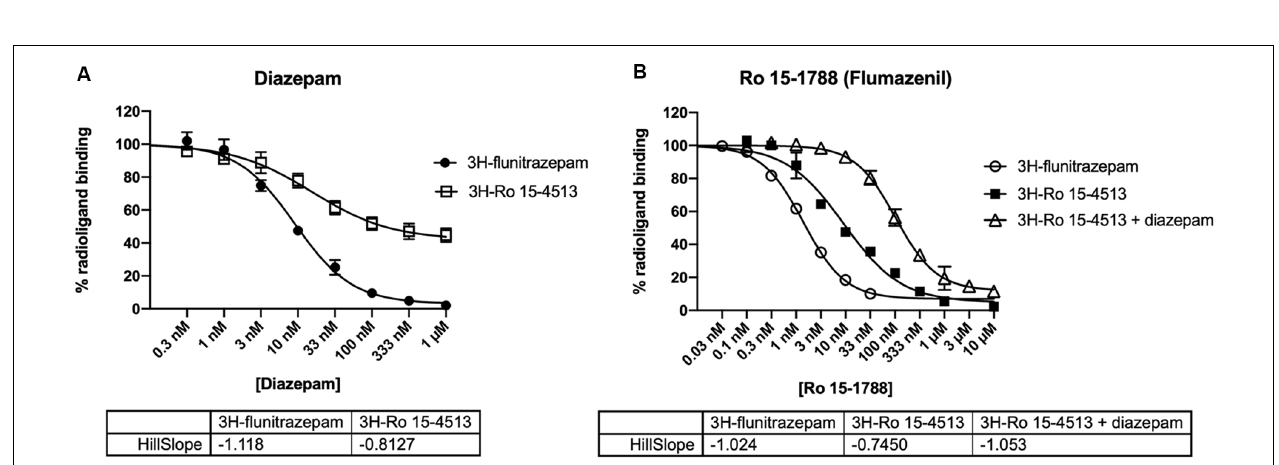
FIGURE 4 | Inhibition of radioligand binding to rat cerebellar membranes. Rat cerebellar membranes were incubated with 2 nM 3 H-flunitrazepam (circles), 5 nM 3 H-Ro 15-4513 (squares), or 5 nM 3 H-Ro 15-4513 + 5 µ M diazepam (triangles) in the presence of various concentrations of the displacing ligand [diazepam in panel (A) and Ro 15-1788 (flumazenil) in panel (B) ]. The data shown are the mean ± SD of three independent experiments performed in duplicates each.